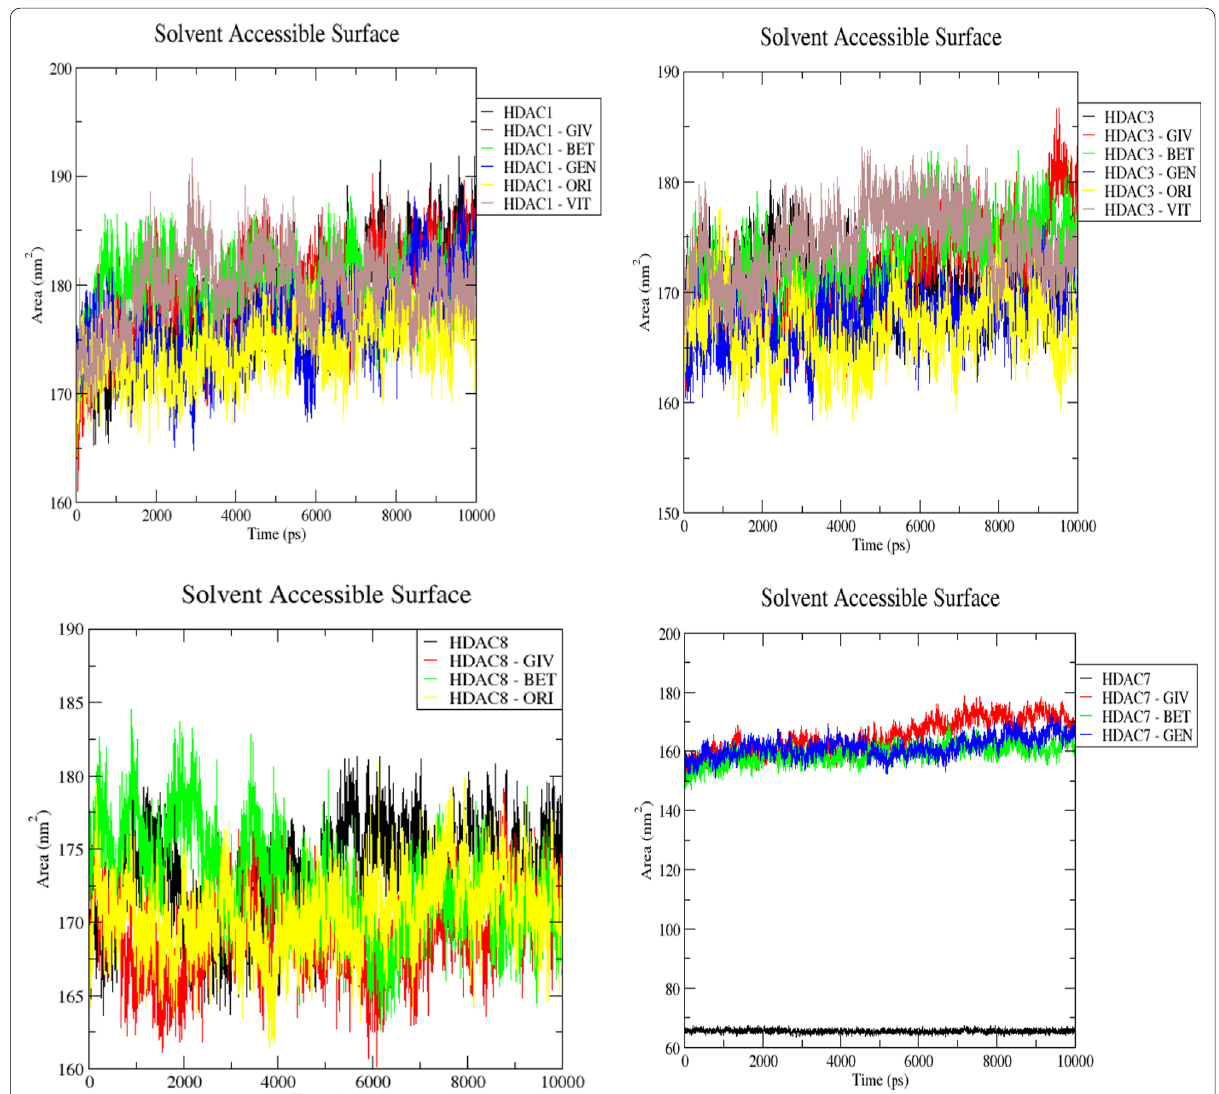
Fig. 13 Solvent accessible surface area (SASA) value vs. time at 300 K for HDAC1, HDAC3, HDAC8 and HDAC7